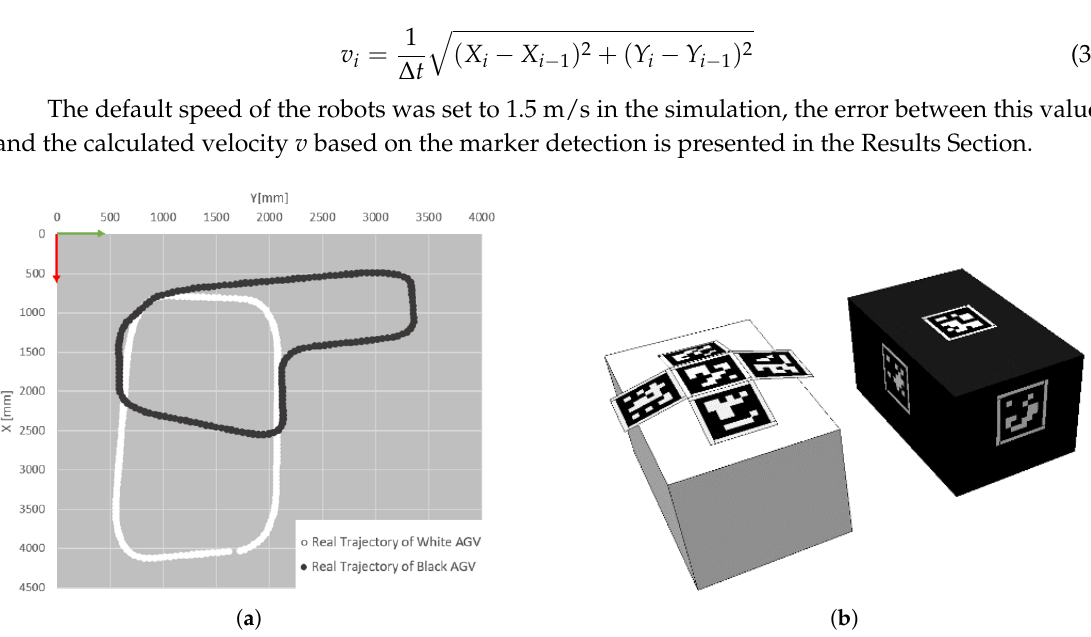
Figure 6. Multiple robots simulation: ( a ) trajectories of the robots in the previously described environment; ( b ) marked robots, the size of the tags was set to 170 × 170